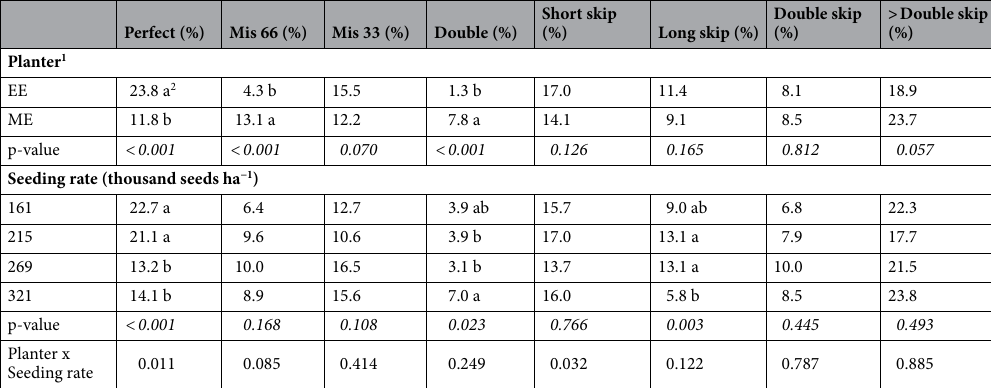
Table 1. Effect of planter type, seeding rate, and their interaction on variables from plant position classification for all US studies. References: percentage of perfectly spaced plants (Perfect), percentage of plants misplaced by 66% (Mis 66), percentage of plants misplaced by 33% (Mis 33), percentage of double plants (Double), percentage of short skips plants (Short-skip), percentage of long skip plants (Long-skip), percentage of double skips plants (Double-skip), and percentage of greater than double skip plants (> Double- skip). 1 Planter type: Max Emerge (ME) and Exact Emerge (EE). 2 Letter and ANOVA (analyses of variance) threshold. Different letters mean significant differences among treatments. The values in italics correspond to the p-values.